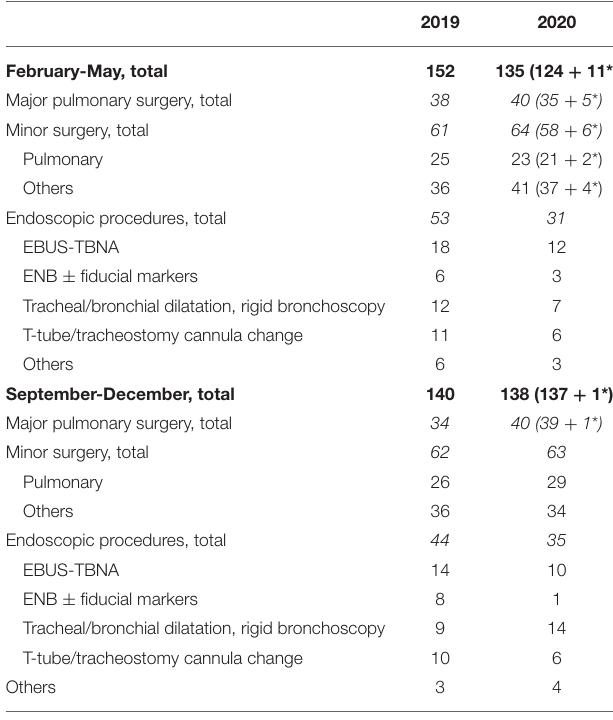
TABLE 1 | Surgical activity during the two phases of Covid-19 pandemic compared to the previous